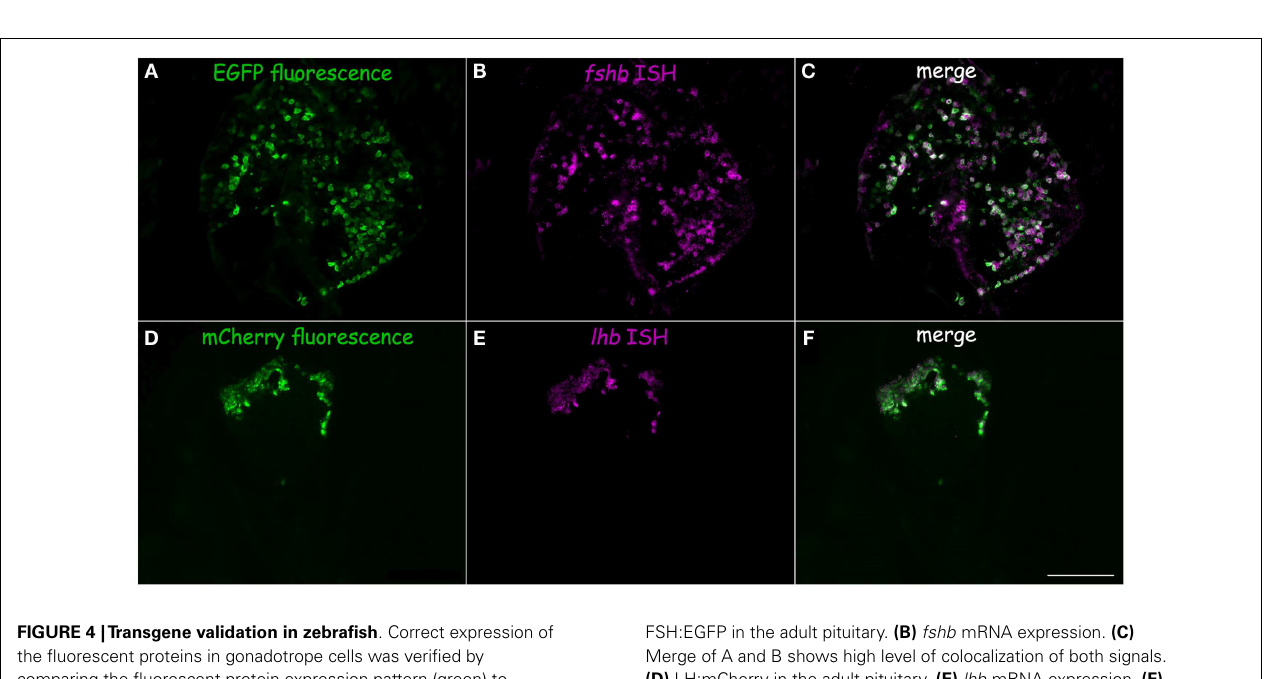
FIGURE 3 | LH:mCherry transgene validation in tilapia . Correct expression of the fluorescent proteins in gonadotrope cells was verified by comparing the fluorescent protein expression pattern (magenta) to immunofluorescence staining using specific antibodies raised against tilapia GtH β -subunit (green).